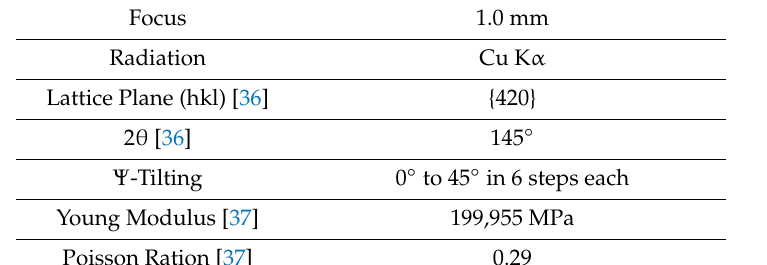
Table 4. Parameters for XRD measurements. Figure 2. Illustration of the as-built IN718 parts manufactured via L-PBF.